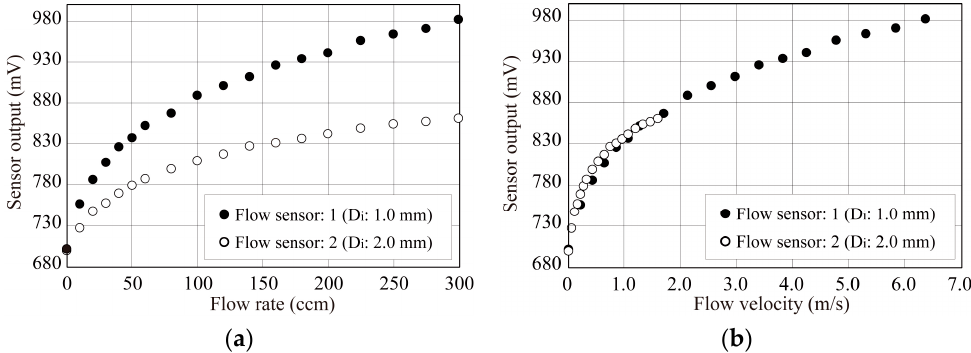
Figure 4. Sensor output vs. flow-rate and –velocity: ( a ) Flow rate vs. sensor output; ( b ) Mean flow velocity vs. sensor output.